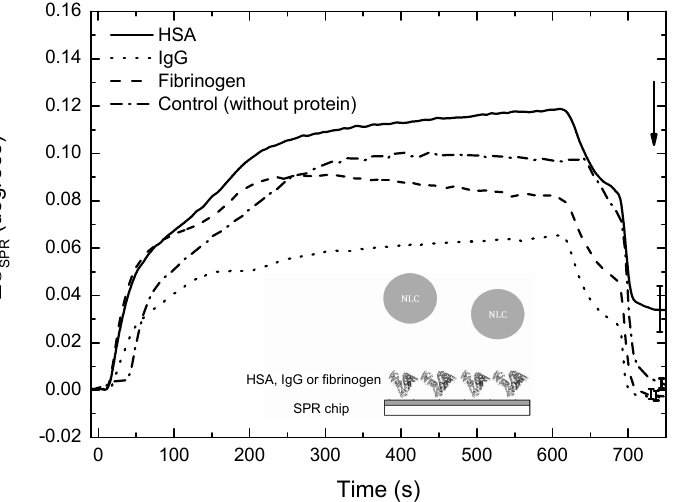
Figure 5. HSA, but no opsonin interacts with NLCs. SPR studies to determine interactions of DXM-NLCs with serum protein having HSA, IgG and fibrinogen. All sensor-grams are presented as mean ± SEM of 3 independent experiments. The arrow indicates the final time of the experiment, when interactions were analyzed.